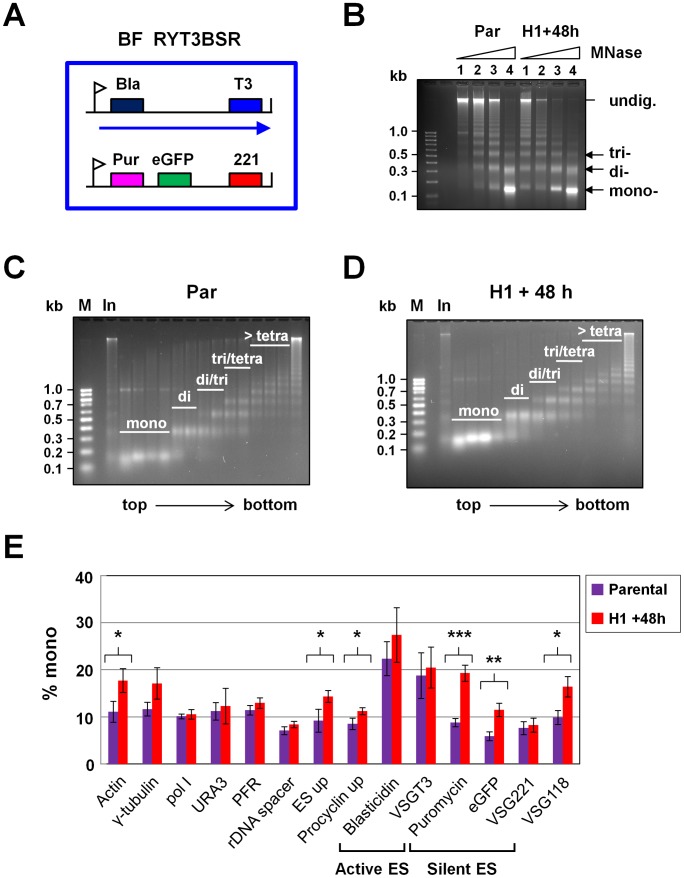
Chromatin structure in the presence of reduced histone H1.
A. Schematic of the T. brucei BF RYT3-H1 cell line in which micrococcal nuclease (MNase) sensitivity experiments were performed after the induction of histone H1 RNAi. The large blue box indicates the BF T. brucei cell, with a blasticidin (Bla) gene integrated in the active VSGT3 ES (T3), and the puromycin (Pur) resistance gene and eGFP integrated immediately behind the promoter of the silent VSG221 ES. The expression site (ES) promoters are indicated with white flags, and ES transcription with an arrow. A construct allowing tetracycline inducible transcription of histone H1 RNAi (H1) from opposing T7 promoters (facing arrows) has also been introduced into these cells using a hygromycin resistance gene (Hyg) transcribed from an rDNA promoter (black flag). B. Parental (Par) BF T. brucei RYT3BSR cells and RYT3-H1 cells in which histone H1 had been knocked down by the induction of RNAi for 48 h (H1+48 h) were permeabilized and incubated with increasing concentrations of MNase (Lane 1 = 0.0625 units MNase, lane 2 = 0.125 units, lane 3 = 0.25 units and lane 4 = 0.5 units. Isolated DNA was visualized on ethidium bromide-stained agarose gels, and a characteristic ladder pattern was observed. Products corresponding to DNA that had been bound to mono-, di, or trinucleosomes, as well as undigested DNA (undig.) are indicated. DNA sizes are indicated in kilobases (kb) on the left. C. Sucrose gradient fractionation of MNase-digested chromatin from BF T. brucei RYT3BSR cells (Par). Chromatin in permeabilized cells was subjected to MNase treatment and then loaded onto a 5–30% sucrose step gradient (input). After centrifugation, fractions were removed, and DNA isolated. Fractions 11–24 are shown with top to bottom of the gradient indicated with an arrow. Fractions 1–10 contained very little DNA and are not shown. Fractions containing mono-, di-, di-/tri-, tri-/tetra-, and >tetranucleosomes are indicated with white bars. These fractions were used to create five pools of DNA which were used as templates for qPCR. D. BF T. brucei cells in which histone H1 RNAi had been induced for 48 hours. Chromatin in permeabilized cells was subsequently subjected to MNase treatment and was further analysed as described in panel C. E. Induction of histone H1 RNAi for 48 hours affects the distribution of various T. brucei genomic regions in the mononucleosomal fractions containing open chromatin. Results show qPCR analysis of fractionated, MNase-treated DNA. The amount of each target detected in the mononucleosome pool is plotted as a percentage of the total amount of target detected in all pools. Genomic regions analysed are as indicated in Fig. 3 panel D. The mean of three independent experiments is shown with error bars indicating standard deviation. Histone H1 knock-down resulted in a statistically significant increased distribution of various regions in the mononucleosomal fraction, with asterisks indicating statistical significance (*, P<0.05; **, P<0.01; ***, P<0.001).